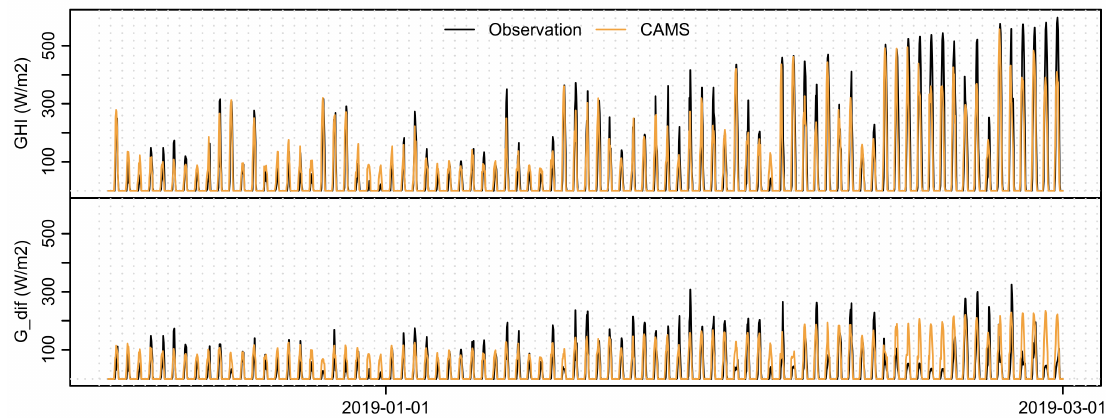
Figure 12. Observed global horizontal (GHI) and diffuse irradiance (G dif ) at the Holzkirchen site compared to the variables from CAMS radiation service for the period 7 December 2018 to 28 February